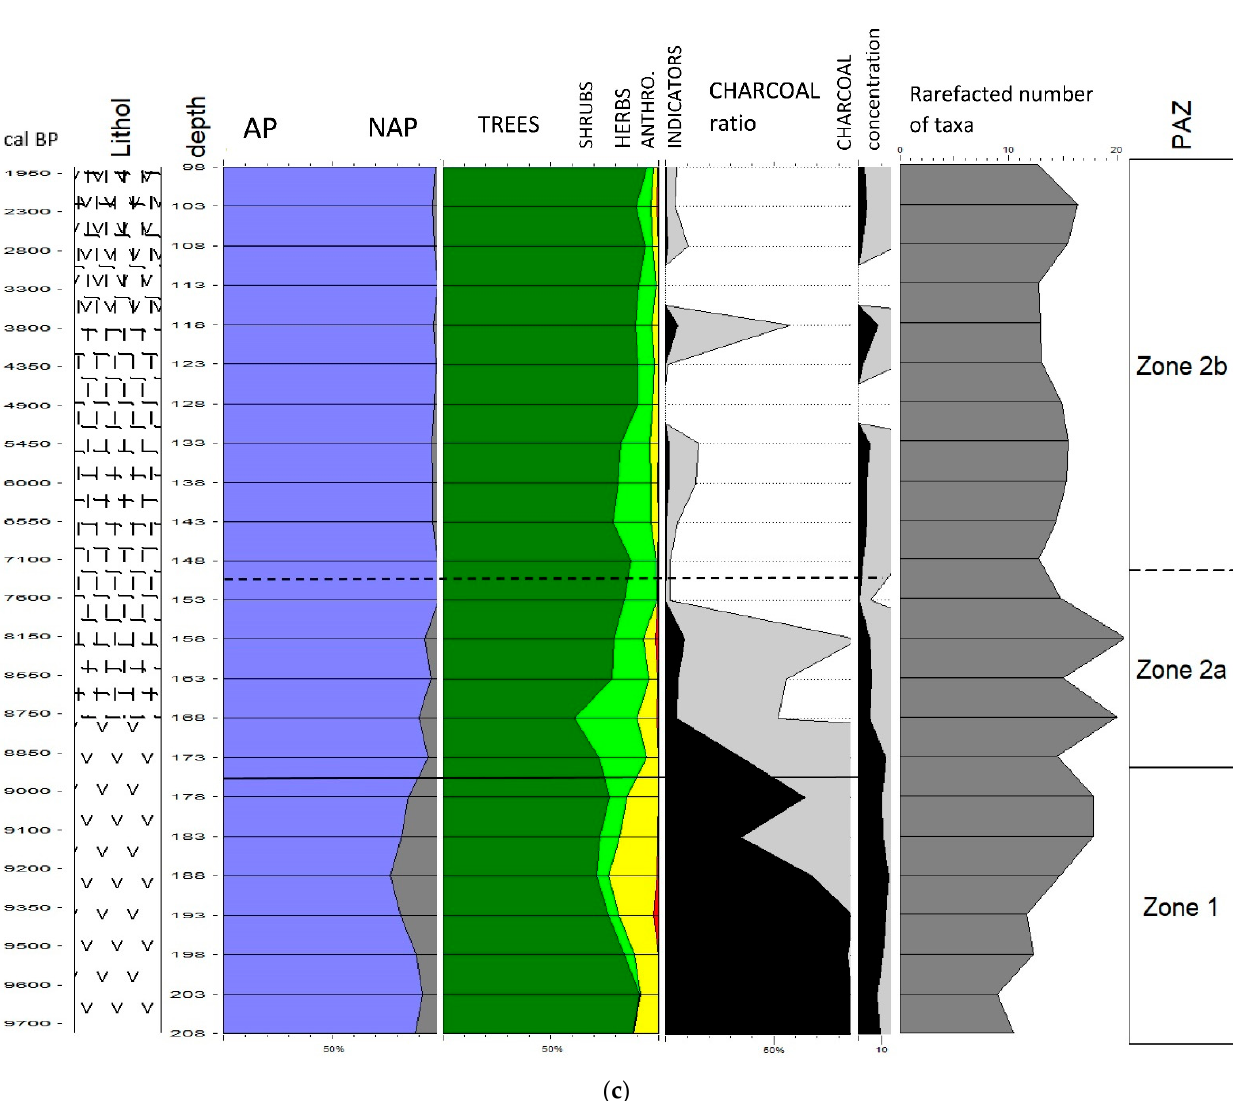
Figure 4. ( a ) Percentage pollen diagram of regional taxa (trees, shrubs and herbs) of the Blatuša mire, followed by microcharcoal curves (ratio and concentrations) as regional fire indicators. The CONISS statistical dendrogram of similarities is used for distinguishing different pollen assemblages (sub)zones (the lithology column is extensively discussed in Table 1). ( b ) Percentage pollen diagram of local taxa (mire and wetland plants) of the Blatuša mire, followed by the curve of non-pollen palynomorphs as indicators of moisture level, fire events or anthropogenic indicators, and a macrocharcoal curve (ratio and concentrations) as a local fire indicator. Due to the ambiguous position of alder and grasses, these two pollen taxa were also included in the diagram, together with anemophilous great burnet. ( c ) Percentage pollen diagram of arboreal (AP) [blue colour] and non-arboreal (NAP) taxa [gray colour] of the Blatuša mire, accompanied by the proportion of different life forms: trees [dark green colour], shrubs [light green colour], herbs [yellow colour] and anthropogenic indicators (AI) [red colour]. Only secondary AI Juglans , Matricaria type, Artemisia , Plantago major-media type, Plantago lanceolata type, Chenopodiaceae, and Urticaceae were observed. The total charcoal ratio and concentration are accompanied by a rarefaction analysis which enables a comparison of taxon richness between samples of different size by standardizing pollen counts to a single sum. Higher NAP, AI and charcoal proportions may suggest possible human impact or highlight a more heterogeneous landscape (a mosaic of woodlands or open forests and grasslands) with more frequent fire disturbances.